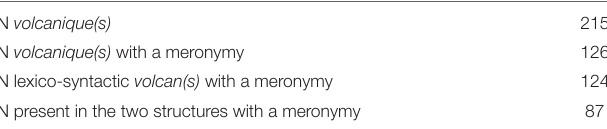
TABLE 1 | Morphological and lexico-syntactical patterns for volcan